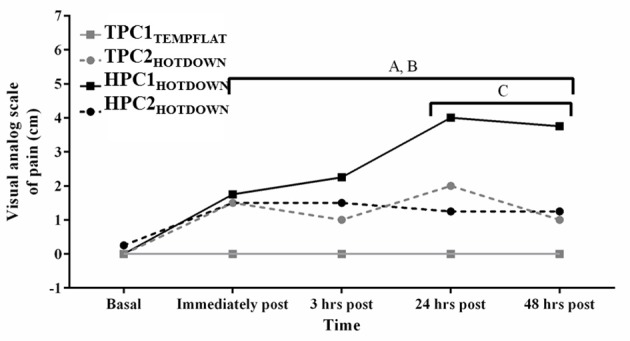
Perceived muscle soreness measured via the Visual analog scale of pain (VAS) immediately before, immediately post, 3 h post, 24 h post, and 48 h post exercise. A, increased (p < 0.005) during TPCHEATDOWN compared to TPC1TEMPFLAT. B, increased (p < 0.001) during HPC1HOTDOWN compared to TPC1TEMPFLAT. C, decreased (p < 0.001) during HPC2HOTDOWN compared to HPC1HOTDOWN. Median data presented. Error bars omitted to maintain clarity.